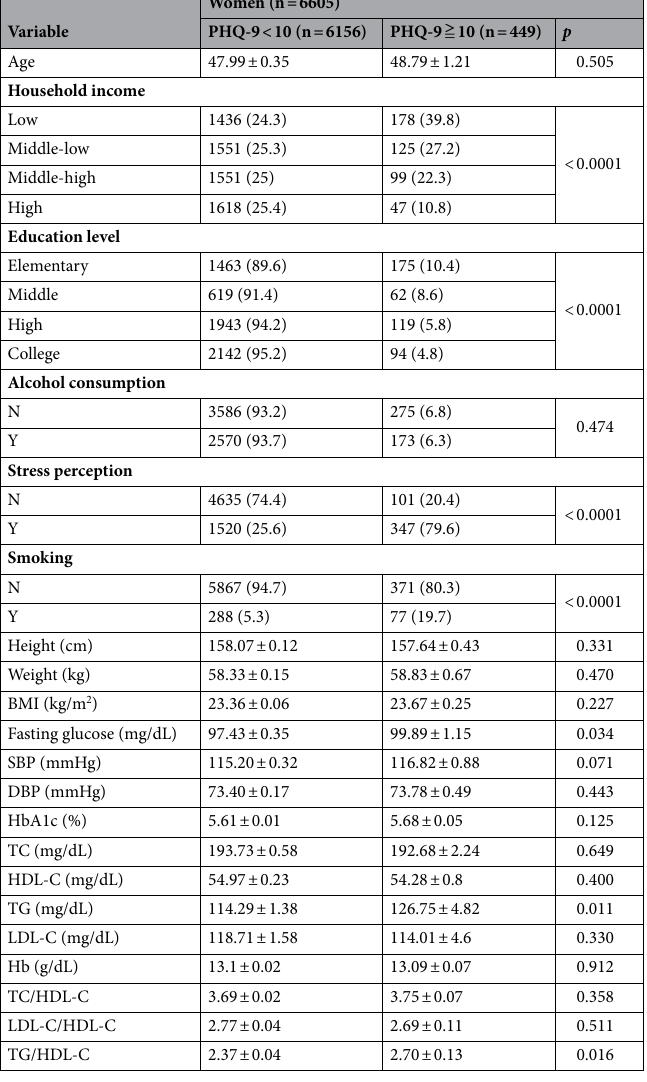
Table 2. Differences between women with and without depression. ‘Y’ represents presence of perceived stress, and ‘N’ represents absence of stress. ‘Y’ represents current smokers and ‘N’ represents non-smokers. ‘Y’ represents current drinkers and ‘N’ represents non-drinkers. Values are presented as number (%) or the mean ± standard deviation. p value was determined through the complex sample Rao–Scott adjusted chi- square test and complex sample generalized linear model T test. PHQ-9 Patient Health Questionnaire-9, BMI body-mass index, SBP systolic blood pressure, DBP diastolic blood pressure, HbA1c hemoglobin A1c, TC total cholesterol, HDL-C high density lipoprotein cholesterol, TG triglyceride, LDL-C low density lipoprotein cholesterol, Hb